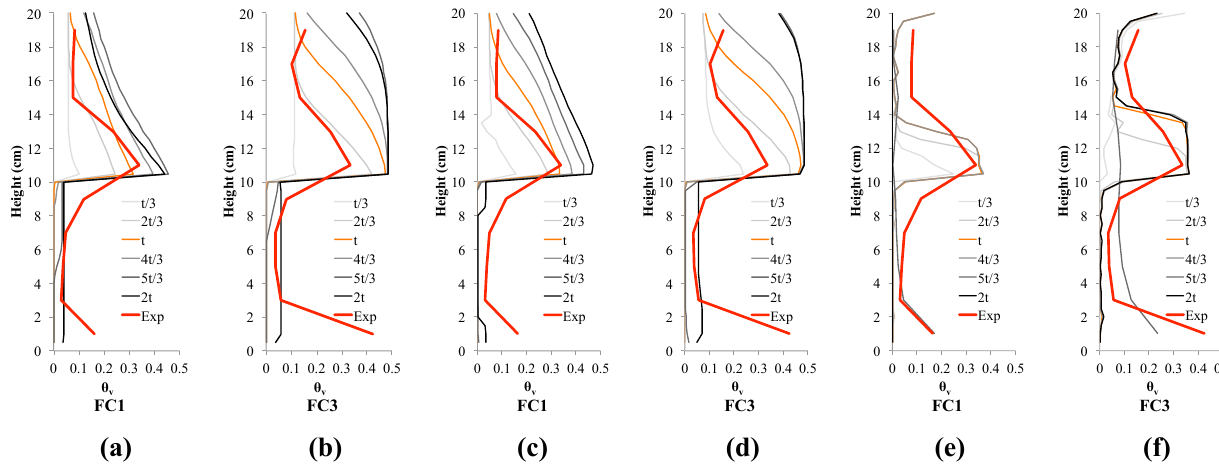
Figure 6. Temporal evolution of simulated water content profiles: (a) FC1 in SNOWPACK RE-model, (b) FC3 in SNOWPACK RE-model, (c) FC1 in SNOWPACK DDA-model, (d) FC3 in SNOWACK DDA-model, (e) FC1 in the 3-D model, and (f) FC3 in the 3-D model. Six profiles are shown in units of the arrival time at snow base in the experiment, t (see Table 2).